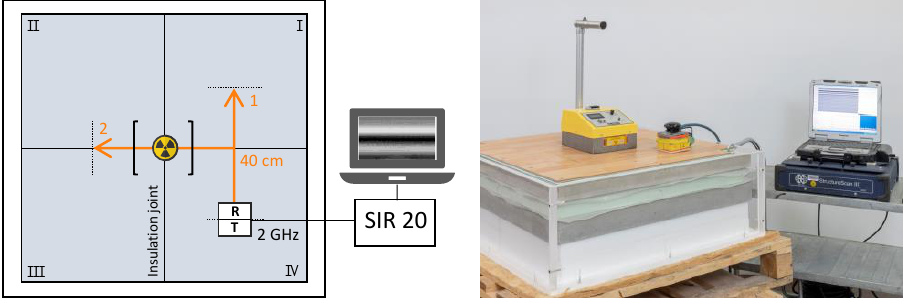
Figure 6. Measurement procedure with 40 cm long radar survey lines 1 and 2. The neutron probe is placed in the center of the